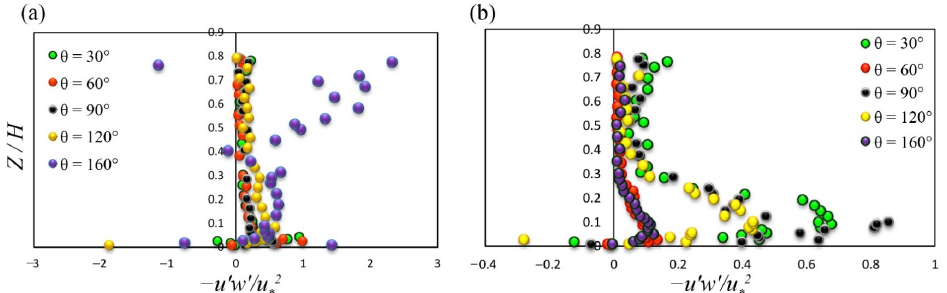
Figure 15. Vertical distribution of u’w’ at the azimuthal planes in the ( a ) un-vegetated bed and the ( b ) vegetated bed at equivalent distances from the abutment (4 cm).